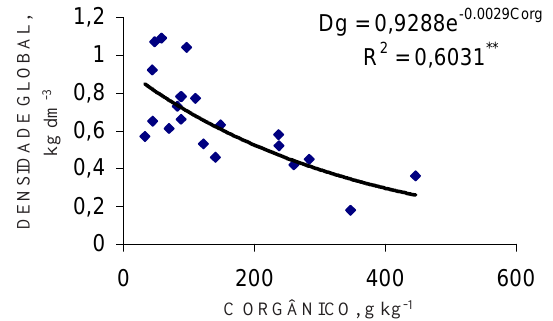
Figura 2. Correlação entre teores de carbono orgânico (CO) e densidade global (Dg) de solos tiomórficos da várzea do rio Coruripe (AL).